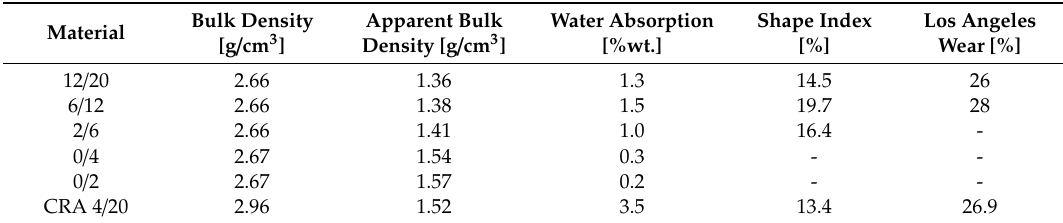
Table 2. Characterization of the